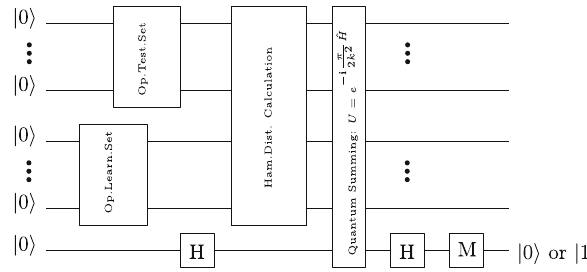
Fig. 2 Quantum circuit classifying Hermitian and non-Hermitian